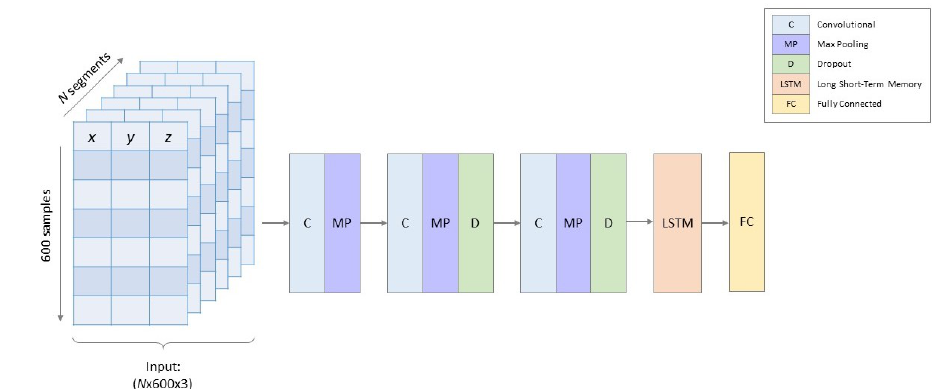
Figure 2. Model architecture of the deep neural network. Acceleration segments with dimension N × 600 × 3 , where N represents number of segments, were used as input. Batch normalization layers are not shown for simplicity. The dimensions of the feature maps before each feature extraction layer are noted below the layers.